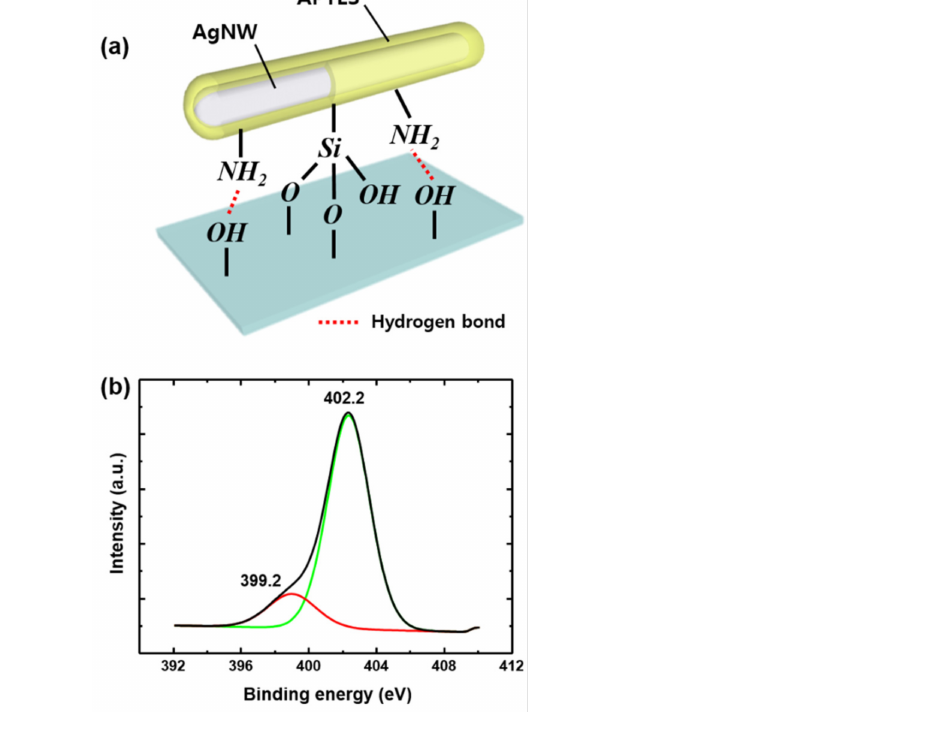
Figure 3. ( a ) Bonding between the APTES-AgNWs and glass substrate. ( b ) N1s XPS profiles of the APTES-AgNWs deposited on the glass